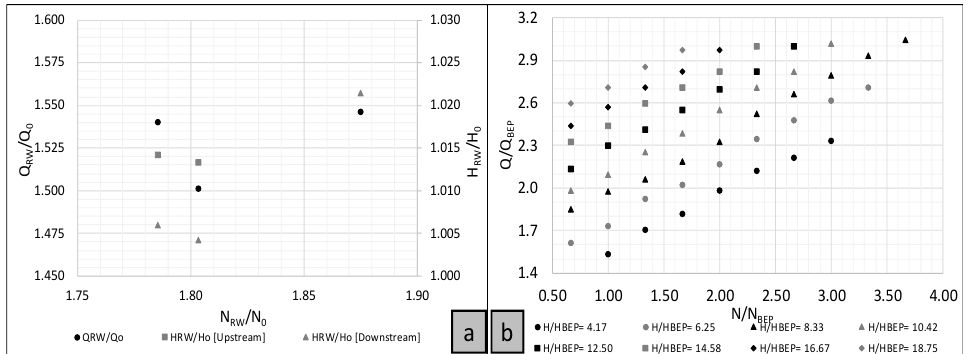
Figure 16. ( a ) 𝑄 RW / 𝑄 0 and H RW / H 0 as a function of N RW / N 0 and ( b ) 𝑄 / 𝑄 BEP as a function of N / N BEP and Figure 16. ( a ) Q RW / Q 0 and H RW / H 0 as a function of N RW / N 0 and ( b ) Q / Q BEP as a function of N / N BEP h = H / H BEP for the axial machine. and h = H / H BEP for the axial